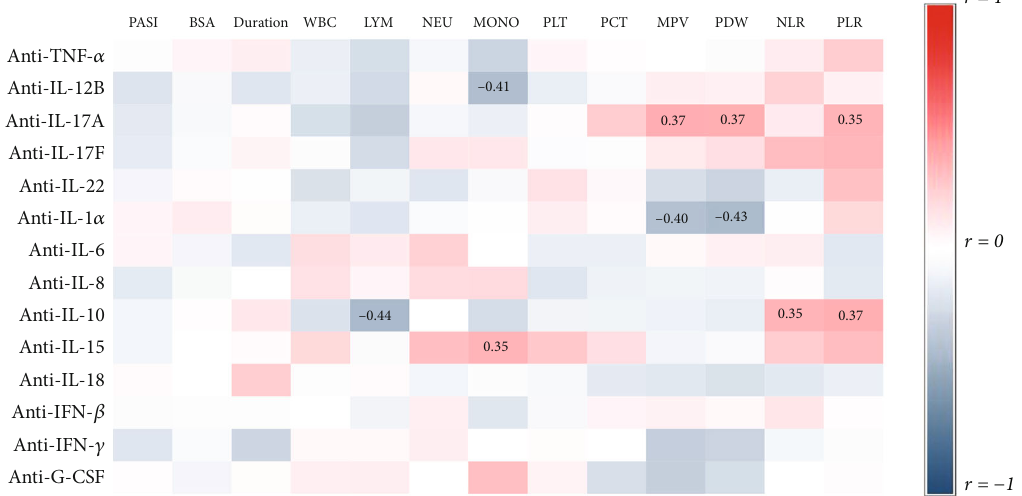
Figure 6: Correlation of serum autoantibodies against cytokines (ACAAs) with clinical parameters in psoriasis patients. Correlations between MFI of auto Abs and PASI, BSA, duration ( n = 44 ), and the absolute number of white blood cell (WBC), lymphocyte (LYM), neutrophil (NEU), monocyte (MONO), platelet (PLT), plateletcrit (PCT), mean platelet volume (MPV), platelet distribution width (PDW), neutrophil-lymphocyte ratio (NLR), and platelet-lymphocyte ratio (PLR) ( n = 34 ) are analyzed by Spearman ’ s correlation. Positive correlations are shown as red, and negative ones are shown as blue. The intensity of color is proportional to the correlation coe ffi cients. Statistically signi fi cant r values ( p < 0 : 05 ) are given in the corresponding rectangle.